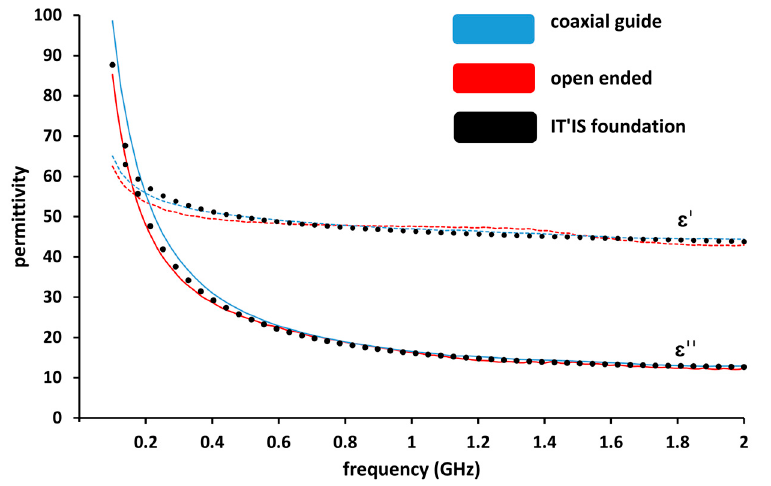
Figure 3. Comparison of real part ( ε ’) and imaginary part ( ε ’’) permittivity measurements of lamb liver using a coaxial guide and an open-ended probe (SPEAG DAK 3.5) as a function of frequency.